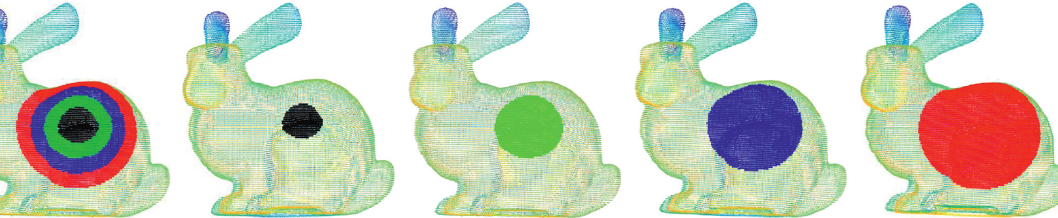
Figure 4: Multiscale receptive fields.